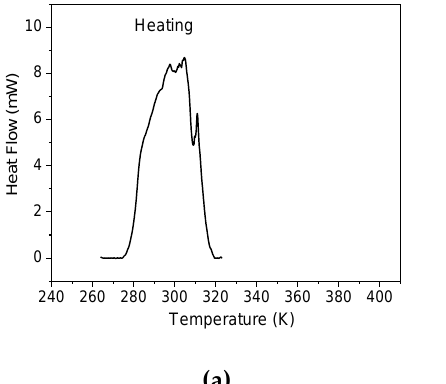
Figure 1. DSC runs for heating ( a ) and cooling ( b ) for the quenched Ni 51 Fe 18 Ga 27 Co 4 single crystals.